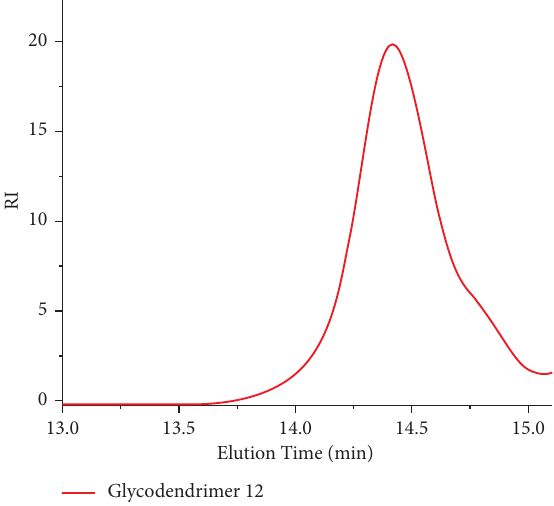
Figure 5: SEC diagram of the constructed glycodendrimer